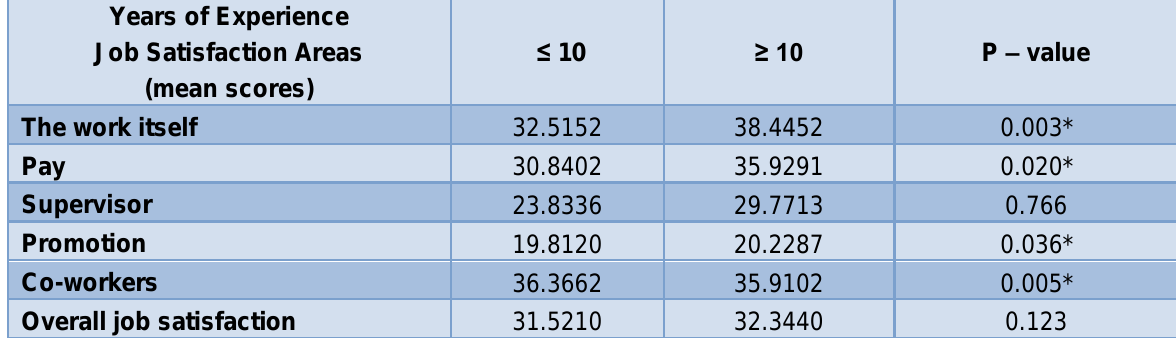
Table 6 Differences in job satisfaction means based on years of experience (n=100) (t-test) * Denotes significant differences among groups at the 0.05